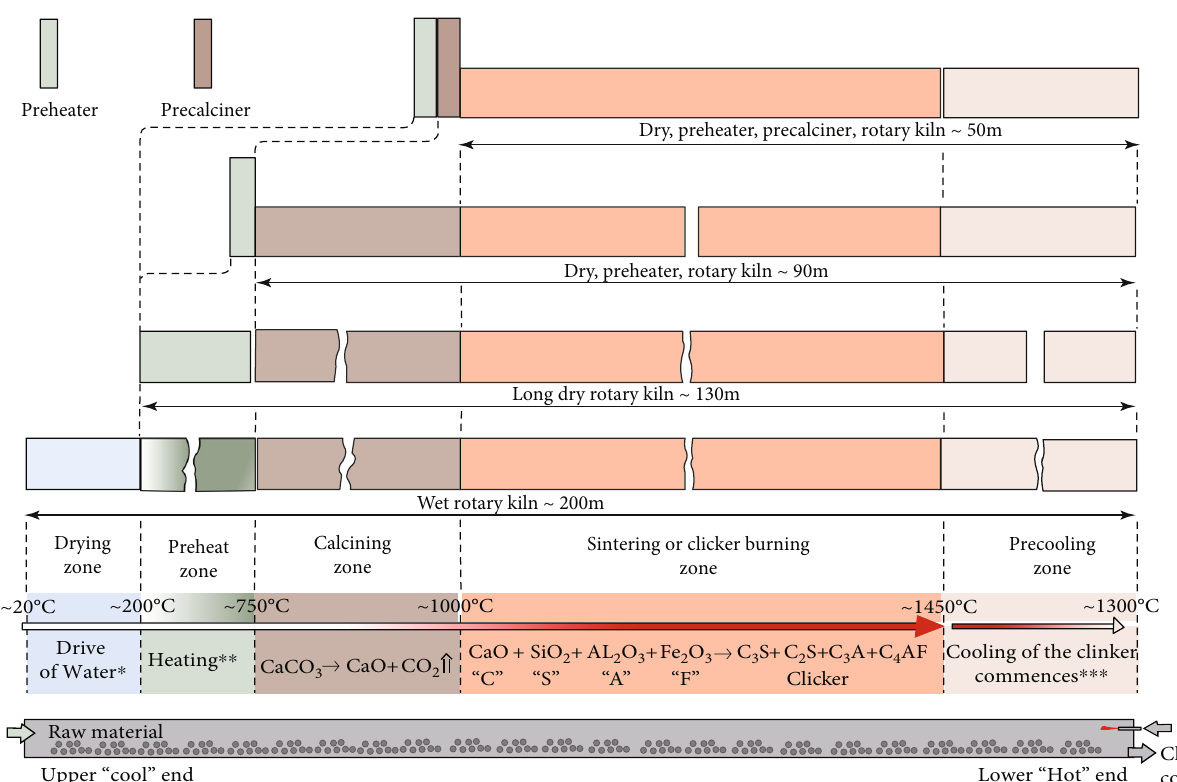
Figure 1: Most important technologies for clinker (cement) production in regard to RKS con fi guration, temperature ranges, and functional zones [9, 10]. ∗ Escape of liquid and adsorbed water. ∗∗ Dehydration of clay minerals and activation of oxides by decomposition of clay minerals. ∗∗∗ The length of this zone and the cooling rate depend on the primary burner position and the type of cooler. The clinker leaves the rotary kiln (a) at a temperature of about 1350 ° C when the sintering zone is close to the RK exit and (b) at a temperature of about 1150 ° C when it is a long cooling zone for satellite